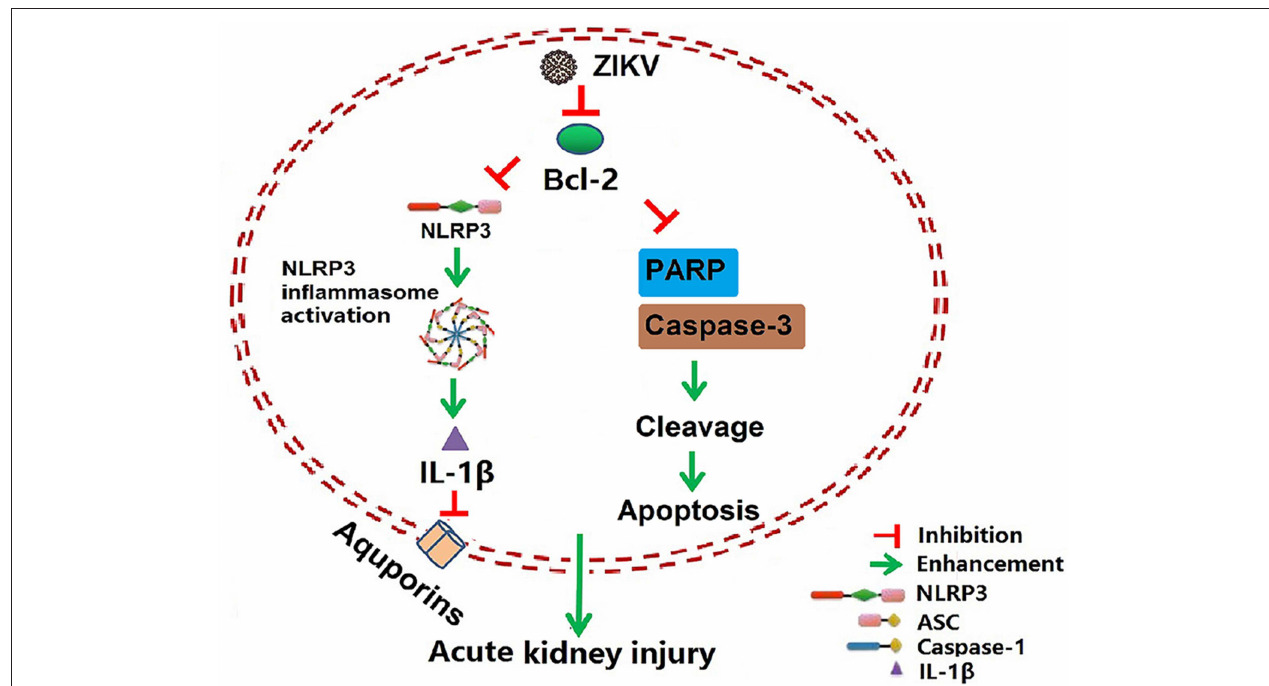
FIGURE 10 | Schematic of the mechanism of AKI induced by ZIKV infection. ZIKV infection promotes NLRP3 inflammasome activation and IL-1 β production in the kidney by suppressing the expression of Bcl-2. IL-1 β attenuates the expression of aquaporins, thus leading to water re-absorption disorder and renal cell injury. In addition, ZIKV infection increases PARP and caspase-3-mediated renal apoptosis via inhibiting Bcl-2, which further enhances the kidney injury. Overall, ZIKV infection induces acute kidney injury through activating NLRP3 inflammasome via suppressing